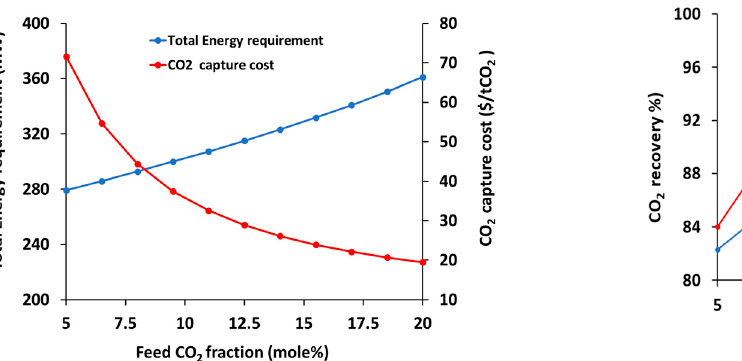
Figure 4. Effect of CO 2 fraction of flue gas on the CCS unit performance ( left ) total energy requirement ( right ) CO 2 recovery (%).